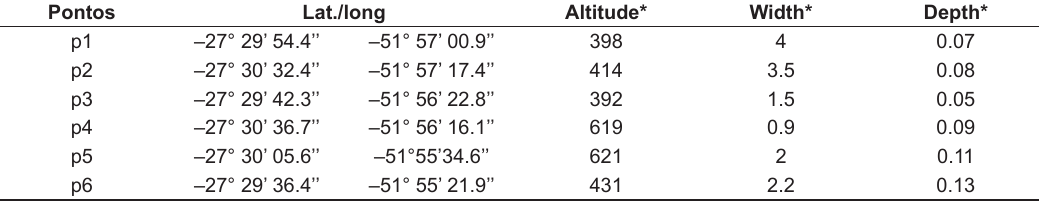
Table 1. Characterisation of the sampling sites located inside and outside of the Mata do Rio Uruguai Teixeira Soares Municipal Natural Park, 2009. Pontos